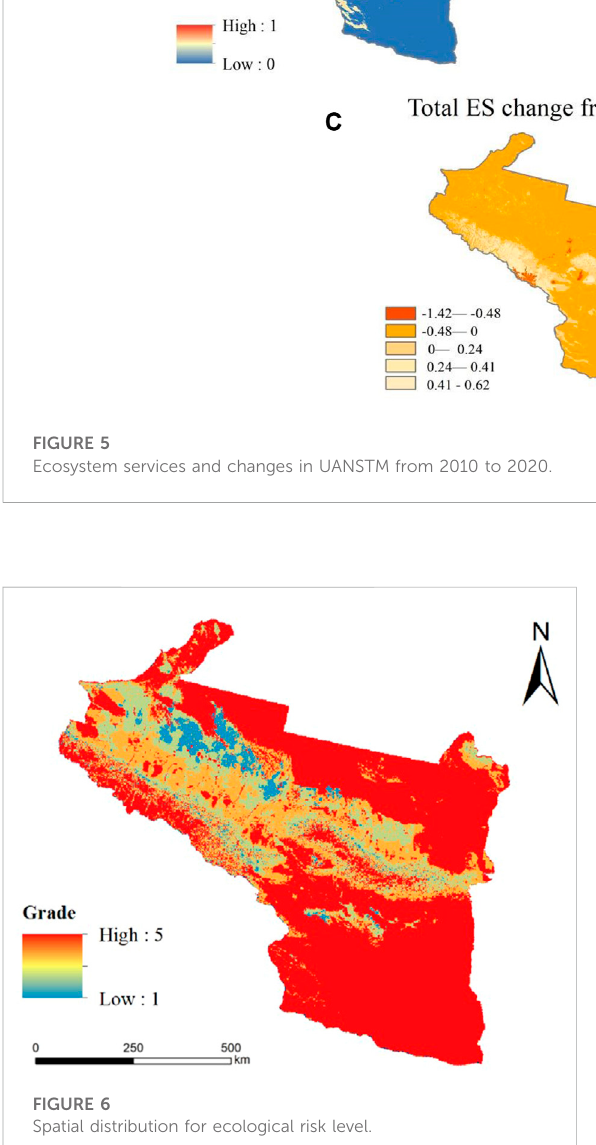
People Autonomous Prefecture, and central Urumqi. The largest increases were observed in the southern part of Changji Hui People Autonomous Prefecture and the southwestern part of Urumqi City.